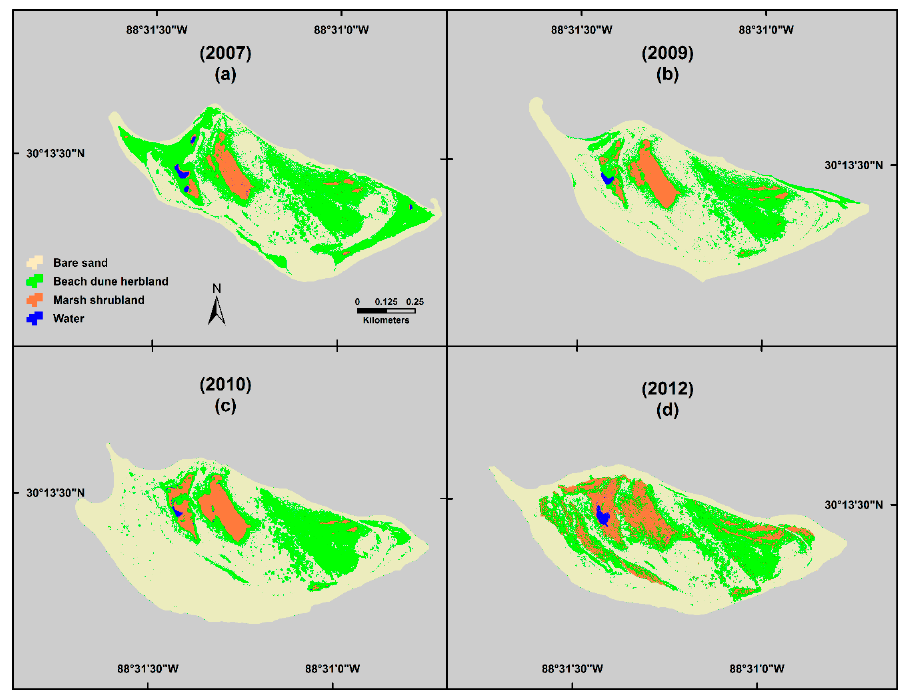
Figure 3. Maximum Likelihood classifications of Sand Island for the years: ( a ) 2007; ( b ) 2009; ( c ) 2010; and ( d ) 2012.